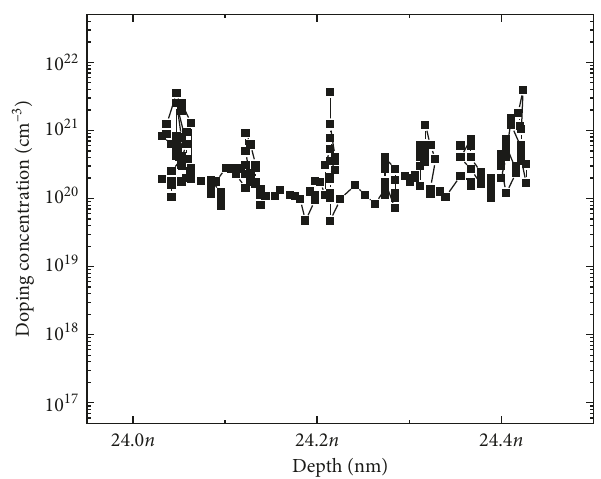
B diode. < > Figure 2: Distribution of N 1300 ° C, measured by spreading resistance method on the angle polished sample [38].